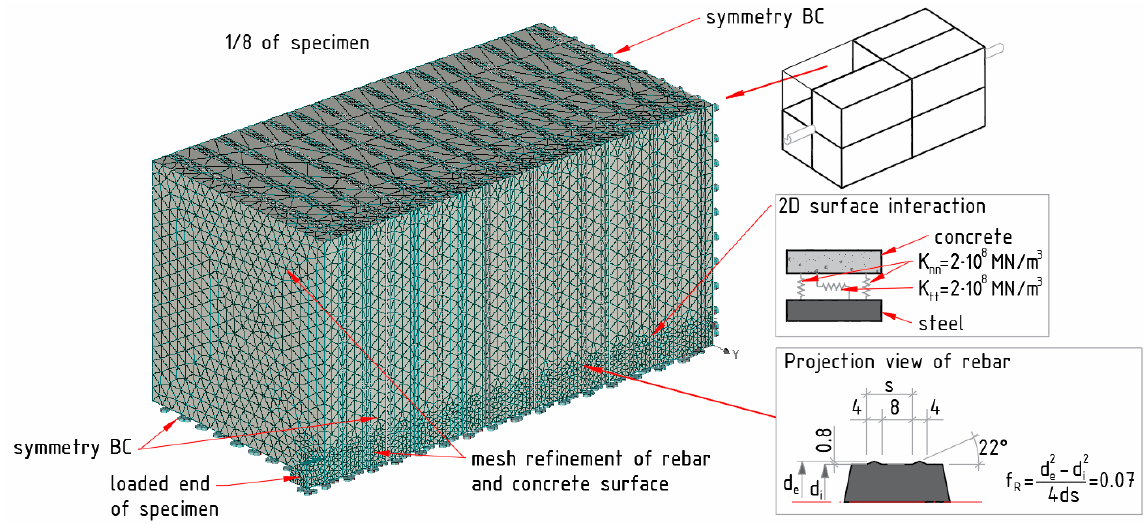
Figure 4. FE Model with important assumptions and boundary